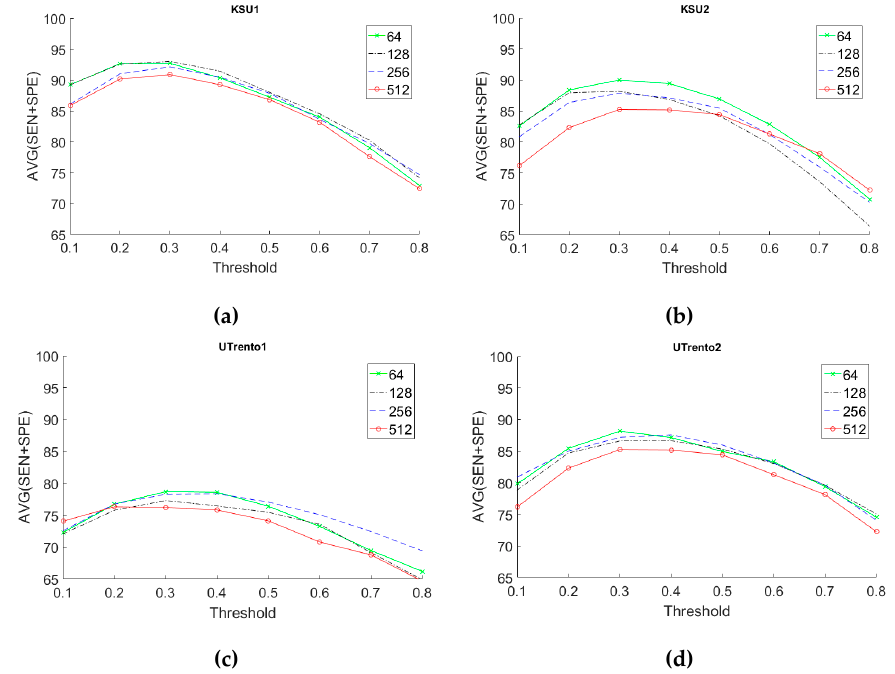
Figure 12. E ff ect of the hidden layer size and the presence thresholds T p on the AVG score for Model 2: ( a ) KSU1 dataset, ( b ) KSU2 dataset, ( c ) UTrento1, and ( d ) UTrento2.